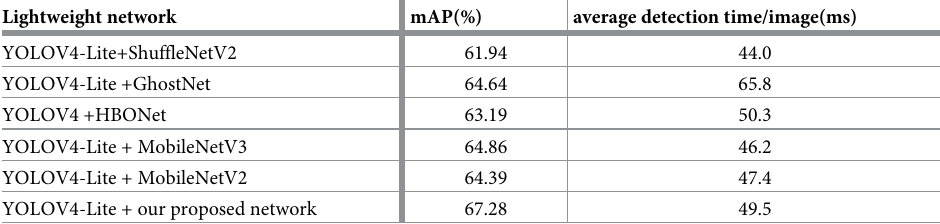
Table 10. Results for different lightweight networks on object